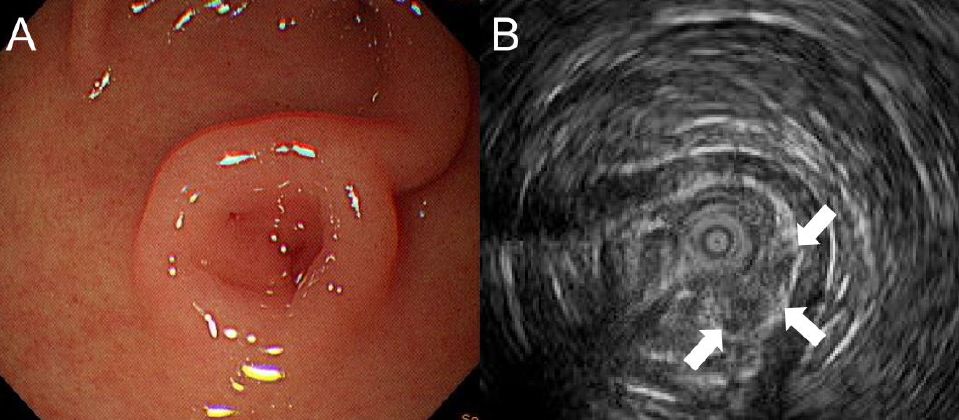
Figure 1. ( A ) Esophagogastroduodenoscopy revealing one oval subepithelial lesion with central um- bilication located in the gastric antrum measuring approximately 10 mm in diameter. ( B ) Endoscopic ultrasonography showing that the lesion was hypoechoic, heterogeneous with ill-defined margins, measuring 4.8 × 2.7 mm in size, arising from the submucosa